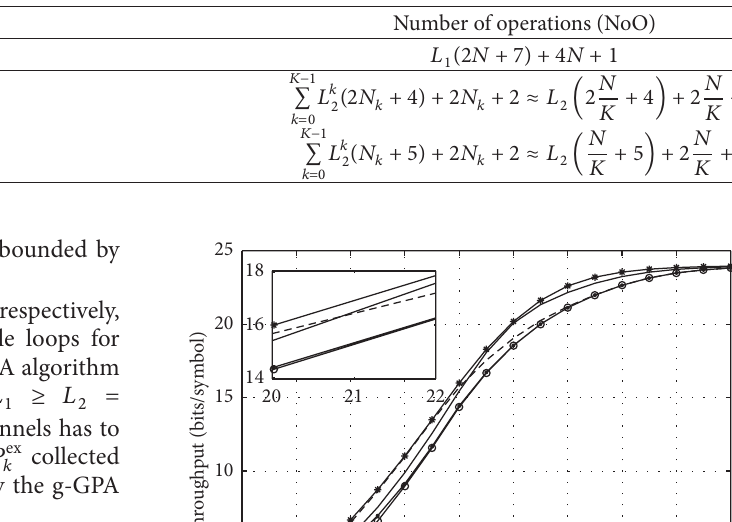
Table 1: Computational analysis for both GPA and g-GPA algorithms.